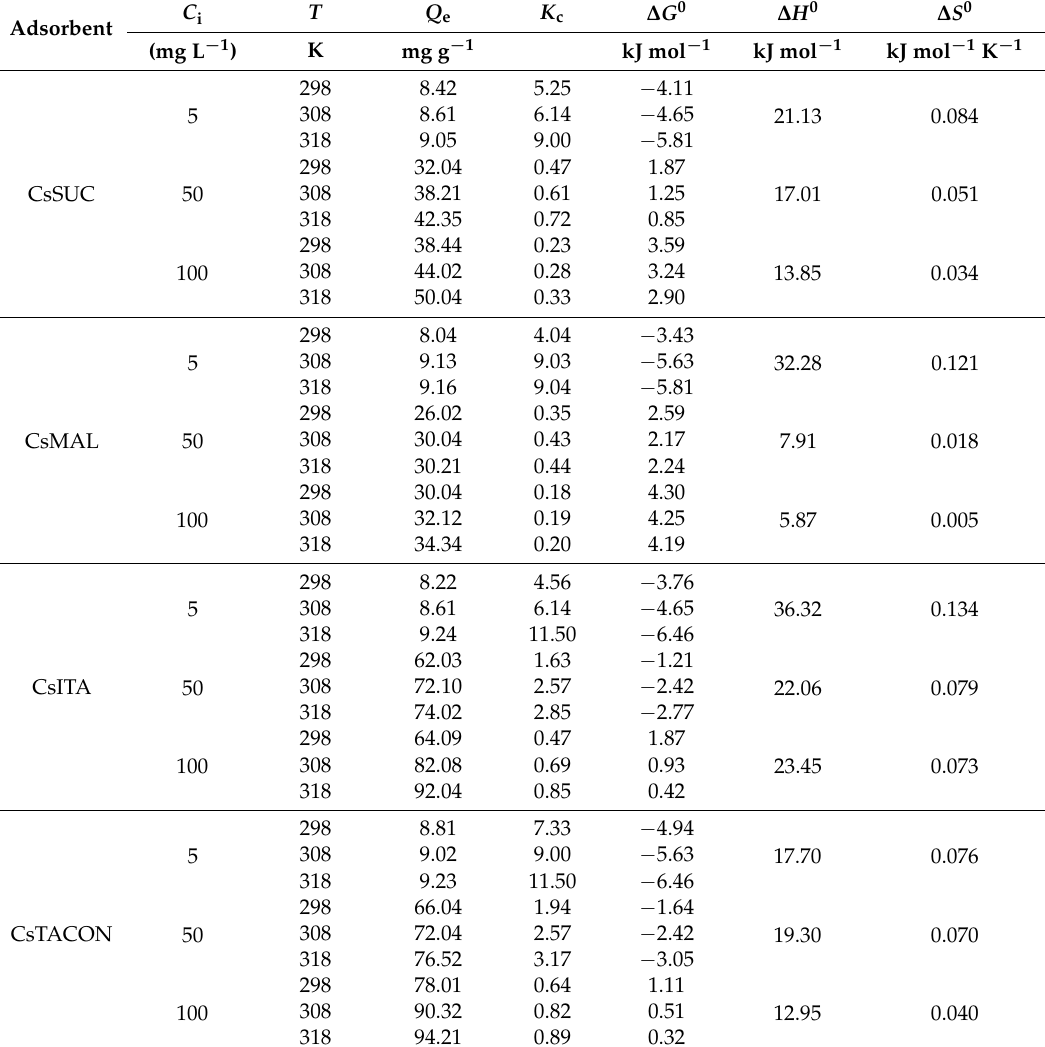
Table 4. Thermodynamic parameters for the adsorption of DCF onto chitosan grafted derivatives. C Adsorbent